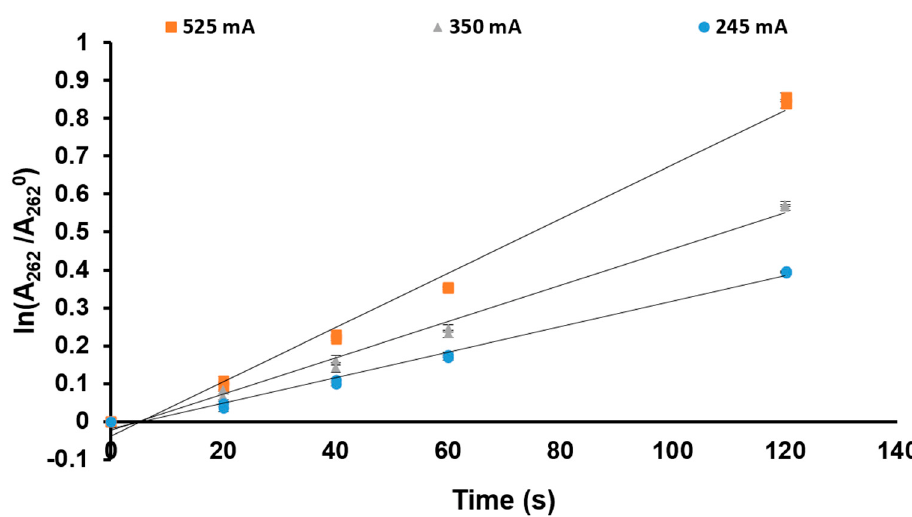
Table 1. UV fluence delivered by bench-scale UV-LED reactor at each drive current (derived using uridine chemical actinometer).